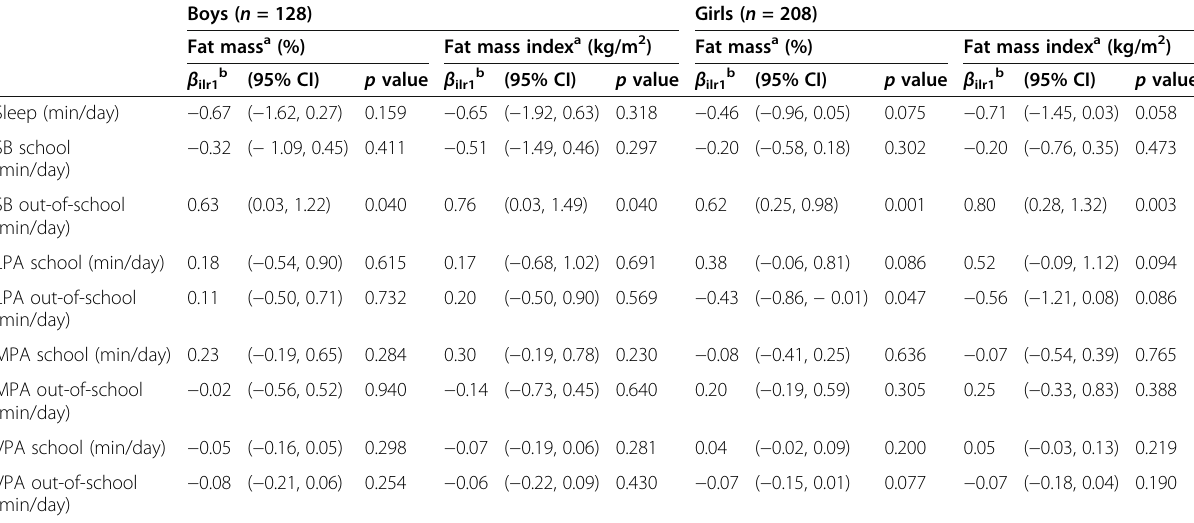
Table 2 Robust compositional regression analysis of associations between 24-h movement behaviors and adiposity